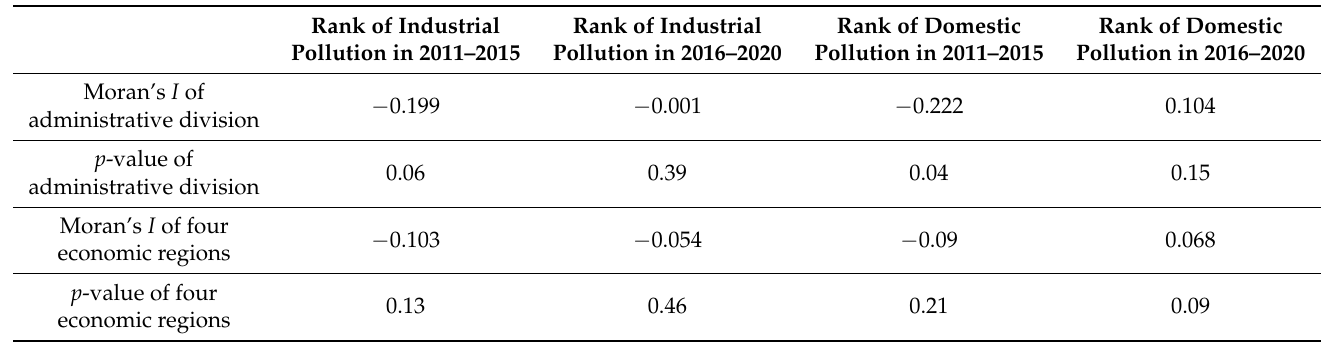
Table 4. Global Moran’s I of the socioeconomic development and pollution